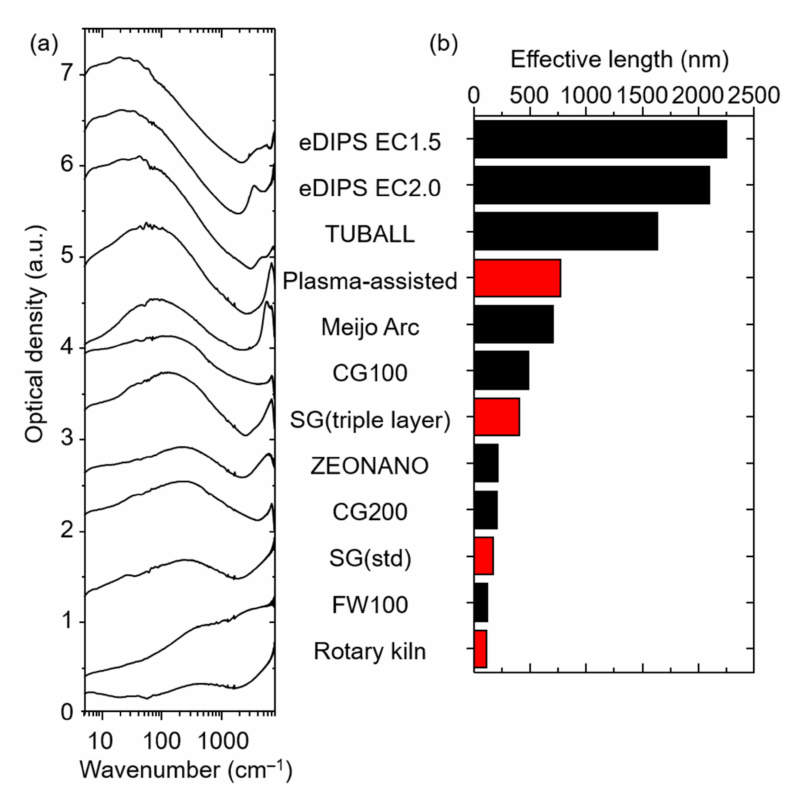
Figure 2. ( a ) FIR absorption spectra of various kinds of CNTs and ( b ) their effective lengths estimated from the absorption